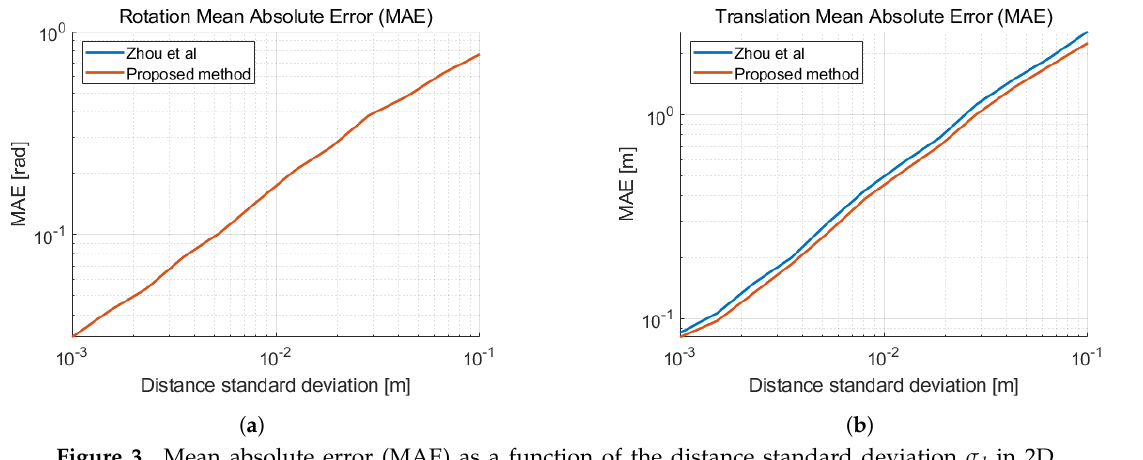
Figure 3. Mean absolute error (MAE) as a function of the distance standard deviation σ d in 2D. ( a ) MAE of the rotation with respect to the ground truth. ( b ) MAE of the translation with respect to the ground